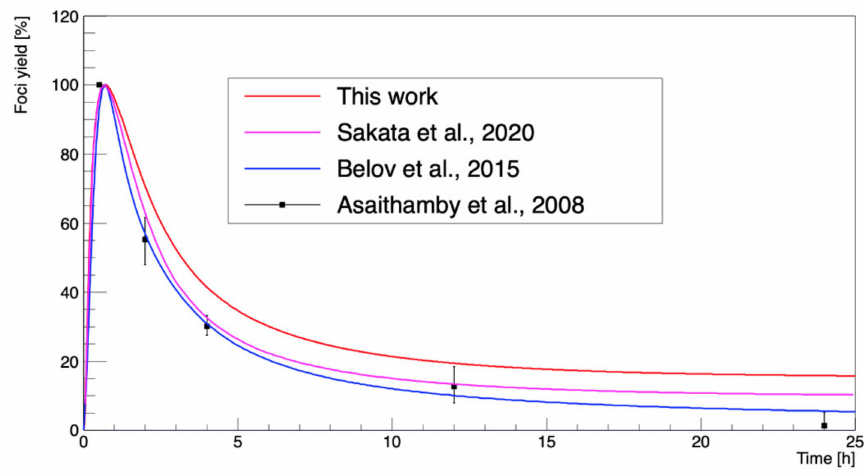
Figure 7. The γ -H2AX yield as a function of repair time from irradiation by 137 Cs at a dose of 1 Gy. The calculated repair model in this study was compared with the calculations of Belov et al. (2015) [62], Sakata et al. (2020) [15], and the experimental data of Asaithamby et al. (2008)